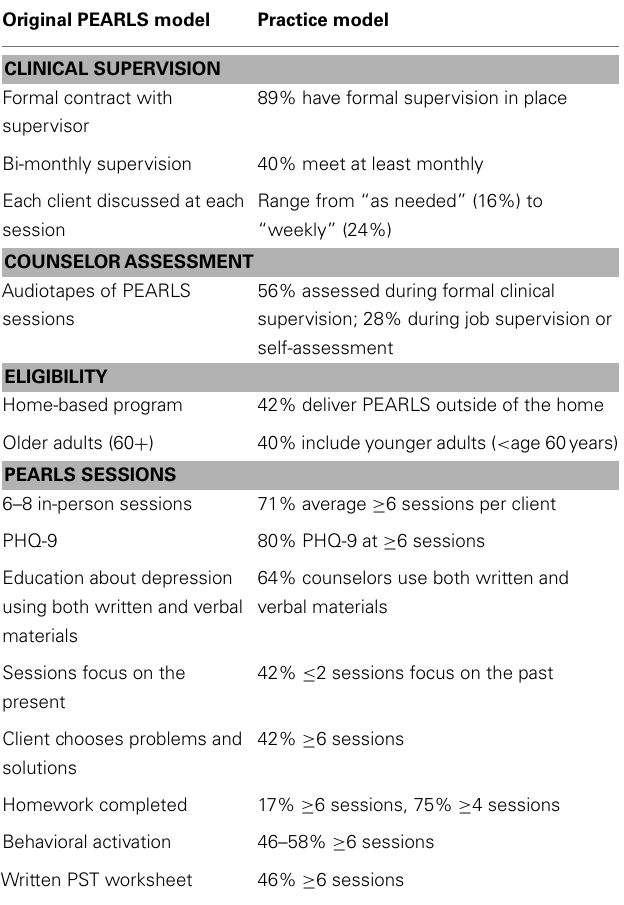
Table 1 | Research to practice: a summary of responses to the PEARLS fidelity instrument as compared to the original PEARLS model